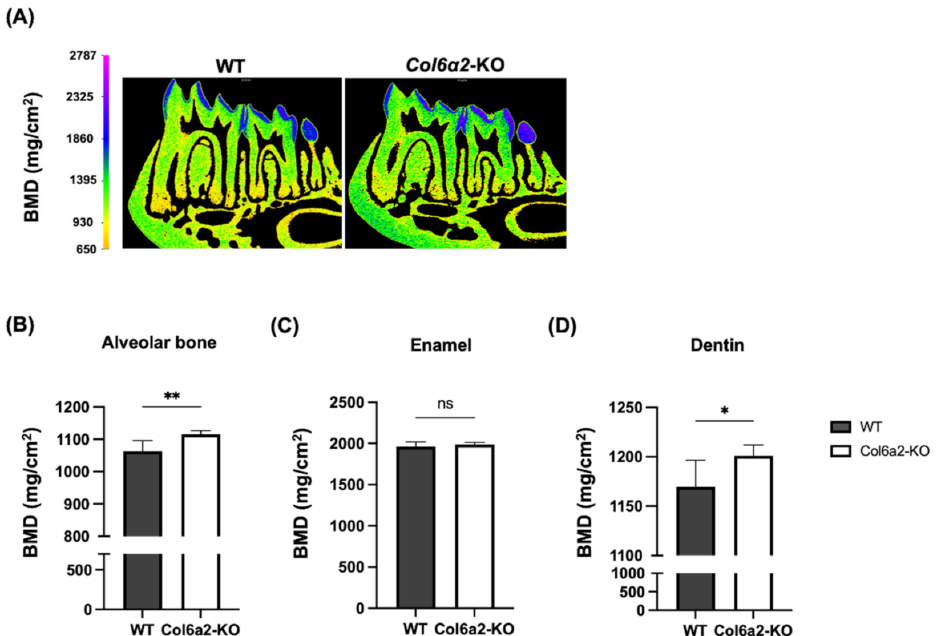
Figure 3. Mineral density with µ CT analysis. ( A ) Heatmap of mineral density from WT and Col6 α 2- KO mice mandibles. Quantification of the data is shown in ( B ): Alveolar bone, ( C ): Enamel and ( D ): Dentin. Bars represent standard deviation ( n = 7/genotype) p -value: * p < 0.05, ** p < 0.01 ns: not